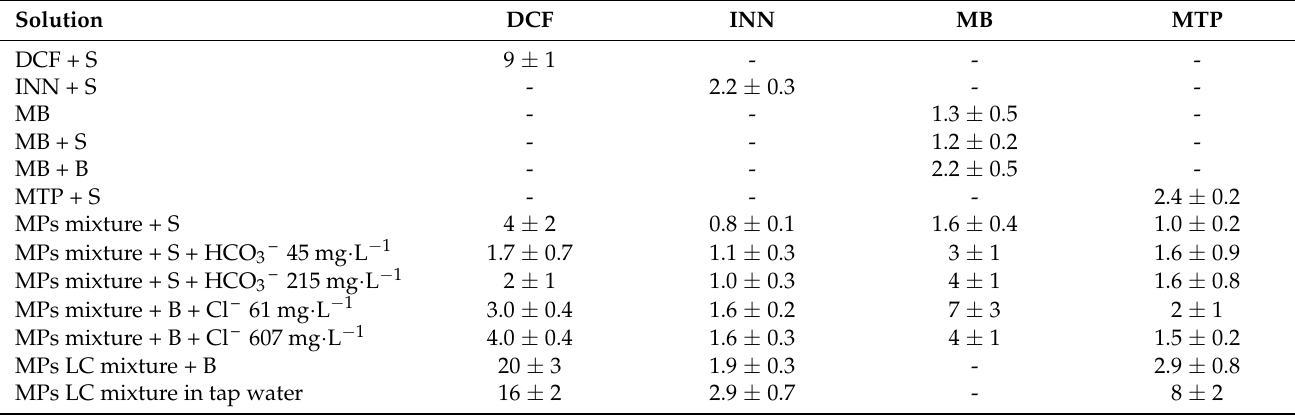
Table 3. Surface reaction rate constant, k (cid:48) [10 − 6 m · s − 1